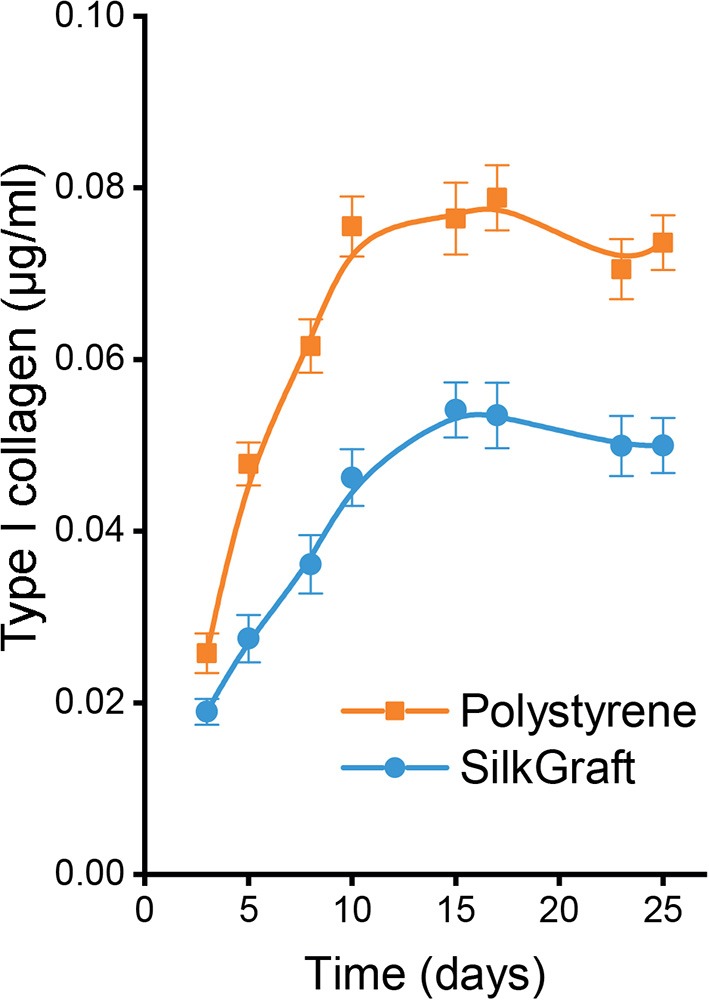
The cumulative assembly of collagen type I (indirectly measured as the stoichiometrically released C-telopeptide of procollagen) was significantly (P < 0.001) lower for HAAFs cultured on SilkGraft than on polystyrene surfaces. Results were normalized per 103 cells. The statistical analysis of these data is shown in Table 3.